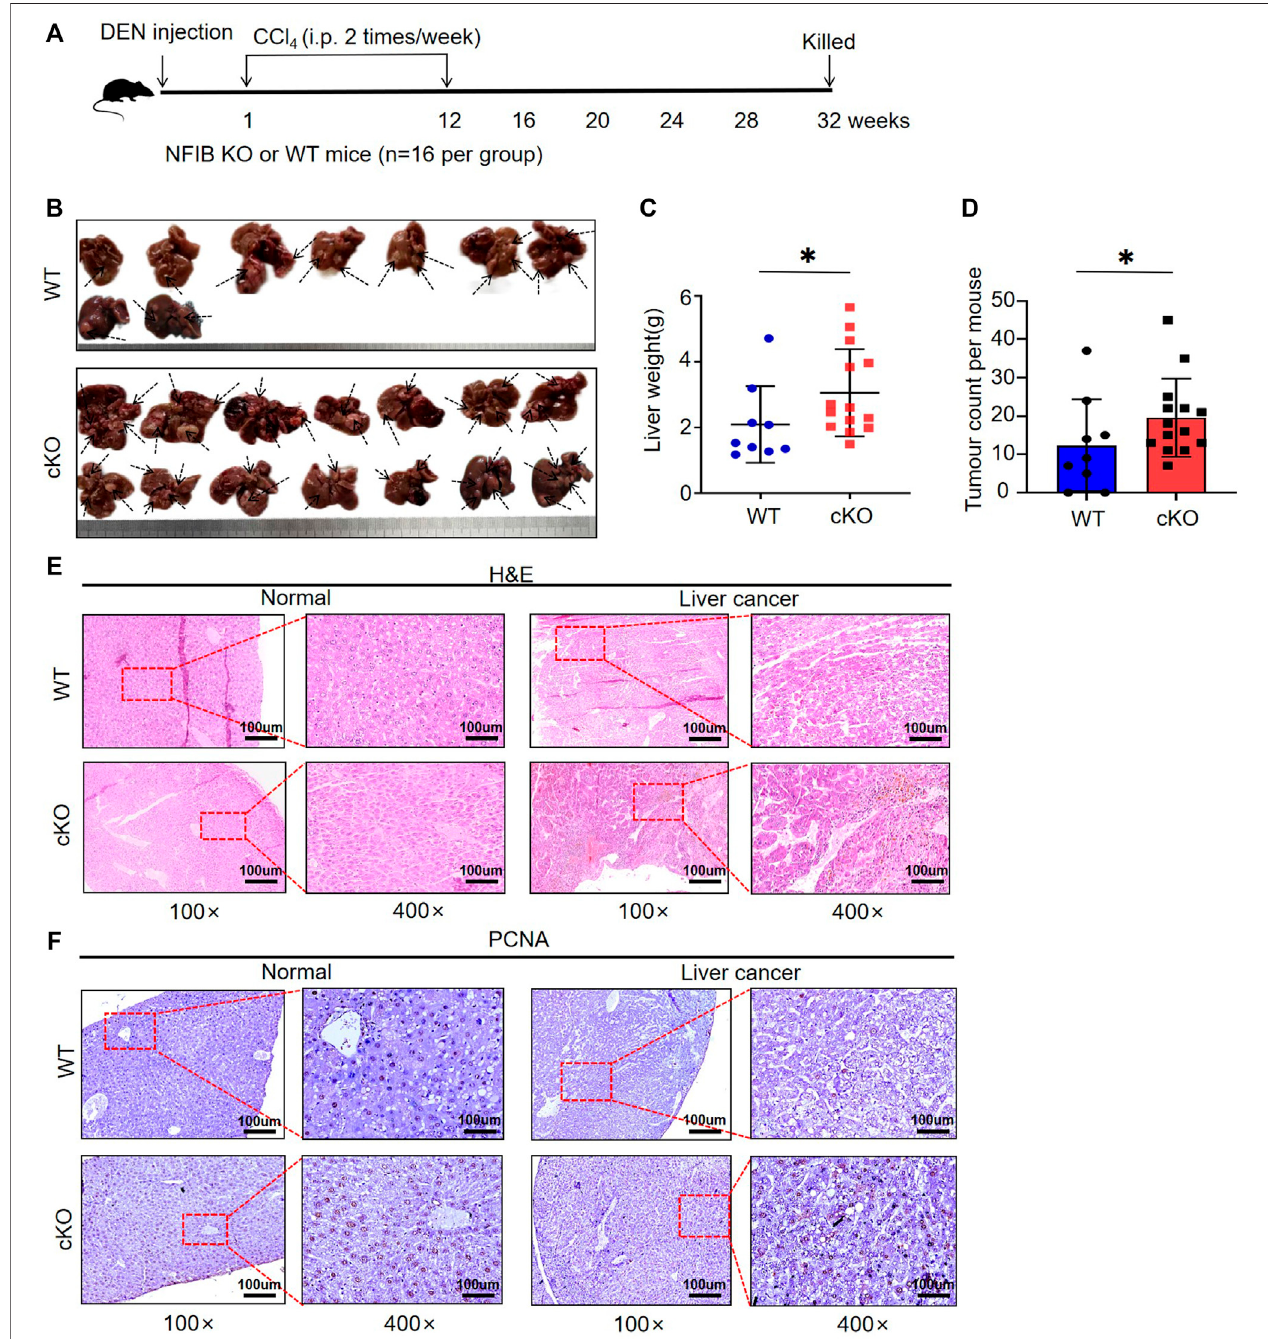
FIGURE2| Hepatocyte-speci fi cknock-outofNFIBpromotes hepatocellular tumorigenesis. (A) Overview ofexperimentaldesign. CohortsofcKO ( n =16)and WT ( n = 16) mice aged 14 – 16 days were administered DEN/CCl 4 . Liver samples were collected at 32 weeks after DEN exposure for histopathological analysis. (B) Gross appearance of livers from the indicated mice. Compared to WT, cKO mice display multiple and more diffuse tumor masses. As the arrow shows. The number of independent tumors was determined for each mouse. Each tumor mass was considered an independent tumor if it was separated from another tumor mass by normal tissue. (C,D) Number of tumors and liver weight. On average, cKO ( n = 14) mice had more tumors and higher liver weight than WT ( n = 9) (bar indicates mean; Mann-Whitney test: *, p < 0.05). (E) Histology of murine hepatocellular neoplasms. Representative photomicrographs of serial sections of normal liver tissue and liver tumors arising in DEN/CCl 4 -treated mice. H&E staining demonstrates tissue morphology. (F) The PCNA staining of the tissues. All scale bars = 100 μ m. Original magni fi cation × 20. DEN, diethylnitrosamine; H&E, haematoxylin and eosin; HCC, hepatocellular carcinoma. *, p < 0.05.